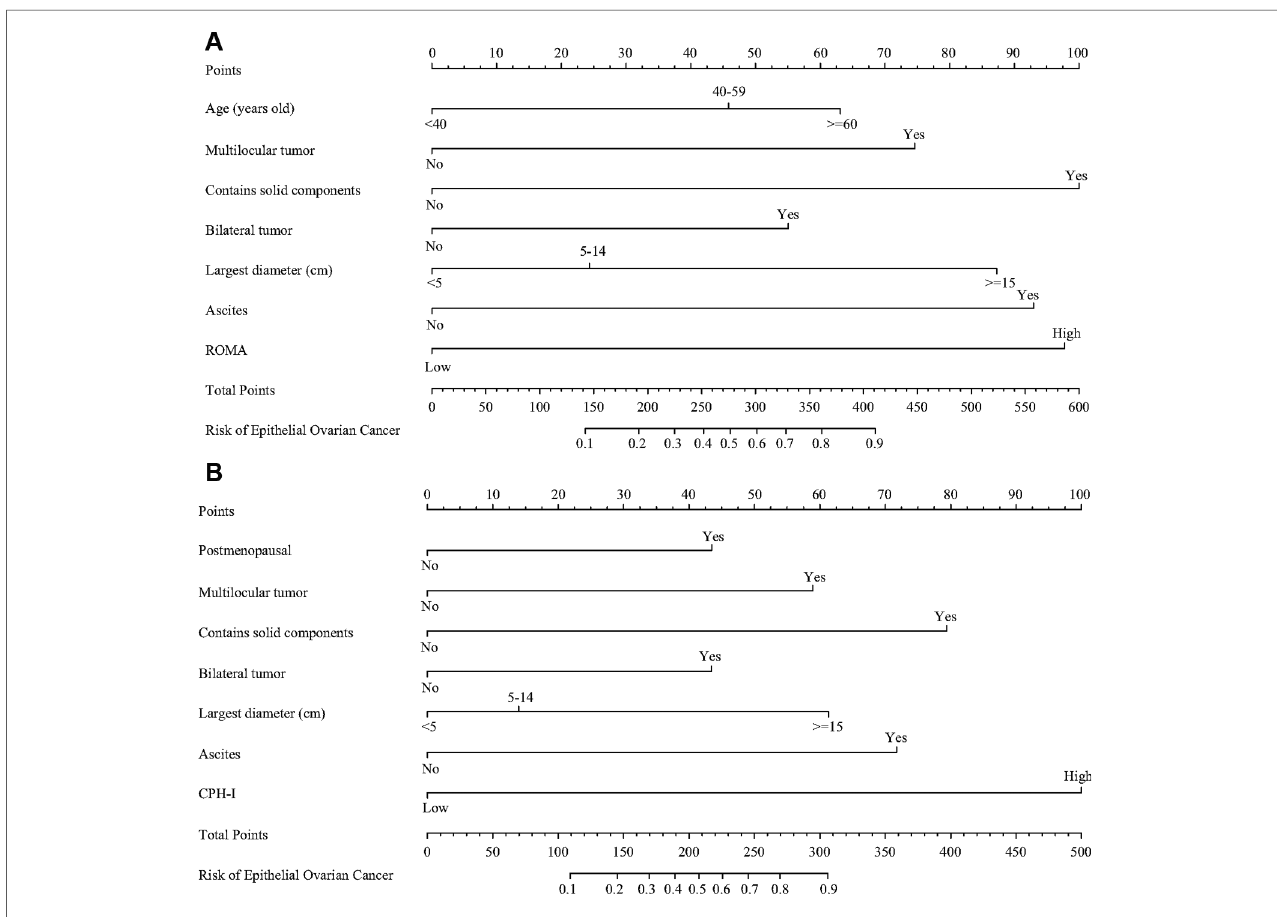
FIGURE 3 Nomograms of epithelial ovarian cancer. ( A ) Nomograms with ROMA; ( B ) nomograms with